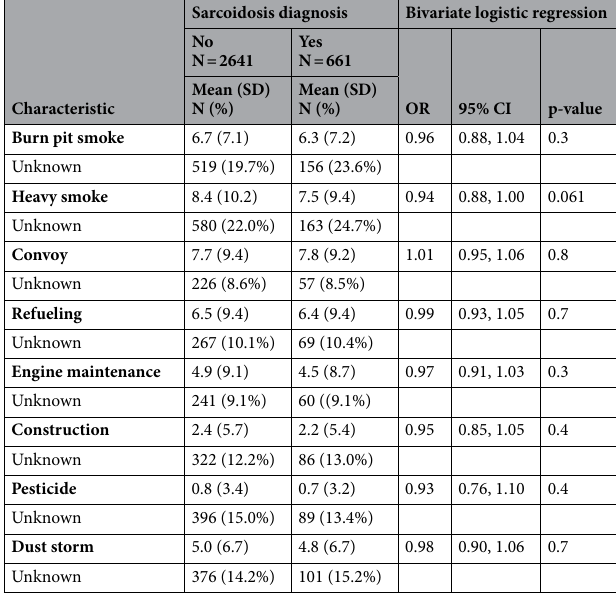
Table 2. Bivariate association between sarcoidosis and cumulative deployment-related exposures (mean (SD) of months over all deployments after October 2001) for cases (n = 661) and age- and sex-matched controls (n = 2641) from the Airborne Hazards and Open Burn Pit Registry participants who used the Veterans Health Administration. SD = Standard Deviation, OR = Odds Ratio, CI = Confidence Interval, n (%) is reported for “unknown” responses for each